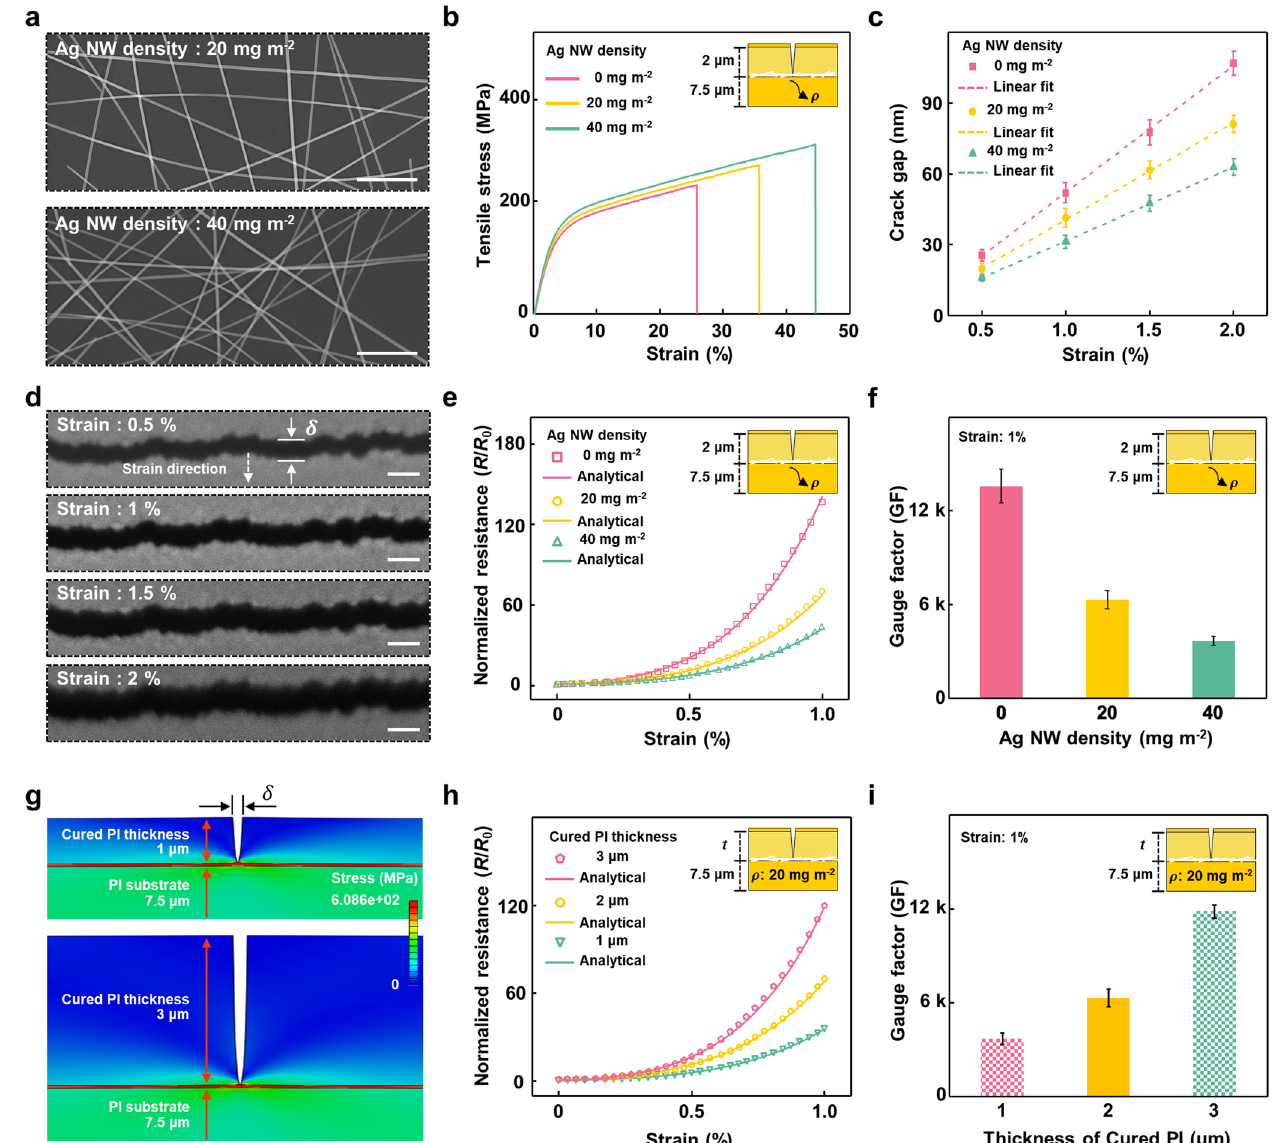
Fig. 3 Mechanical and electrical characteristics of the ULTIMAC sensor with the Ag NW layer. a SEM images of the percolated Ag NW network with different areal densities (20 mg m − 2 and 40 mg m − 2 ) (Scale bar: 1 μ m). b Uniaxial tensile tests of the ULTIMAC sensor, according to the two different densities of the Ag NW mesh. c Crack gap displacement ( δ ) change of crack-based sensor with Ag NW layer according to the applied strain and Ag NW density. d SEM images of crack-based sensor with Ag NW density (20 mg m − 2 ) according to the strain (Scale bar: 100 nm). e Normalized resistance changes in the ULTIMAC sensor, according to the two different Ag NW densities ( ρ ). f Gauge factor (GF) of the ULTIMAC sensor at 1% strain, according to Ag NW density. g Finite-element method modeling of the crack gap displacement, according to the thickness of the cured PI. h Normalized resistance changes of the ULTIMAC sensor, according to the thickness ( t ) of the cured PI. i GF of the ULTIMAC sensor at a 1% strain, according to the thickness of the cured analyzing the PH histogram, we were able to determine the fl oor robot ’ s feet touched the ground (Supplementary Video 2). The slope the robot was currently traveling on. When running on a fl at sensor signals play a signi fi cant role in assessing the condition of ground, the load on the robot leg is evenly distributed so that the both the robot and the ground. As illustrated in Supplementary PH of each foot follows a Gaussian distribution (Fig. 4e). As the Fig. 14 and Supplementary Video 3, the robot ’ s movement across robot climbs a 30° incline, the robot ’ s center of gravity shifts back, a gravel fi eld resulted in yaw and pitch motions due to uneven increasing the PH of the hind legs (legs 3 and 6) and decreasing contact between the robot ’ s feet and the ground. Moreover, there the PH of the forelimbs (legs 1 and 4, Fig. 4f). In contrast, when the were instances where the robot ’ s legs did not touch the ground, robot descends a 30° incline, the load on the forelimbs increases, producing distinctive features. We conducted a long-term driving test on a treadmill to collect resulting in a higher PH in the forelimbs and a lower PH in the a large amount of sensor data (Fig. 4c). The robot ran on a total of hindlimbs (Fig. 4g). We used the Poincaré plot to visualize the overall variability of four terrains: fl at, uphill, downhill, and gravelly, and part of the the robot gait: a smaller, more focused plot represents higher gait collected sensor data is shown in Fig. 4d. The PH histograms of the stability, and a more scattered one indicates the irregularity of the sensors are obtained by plotting counts of the peak against PH. By